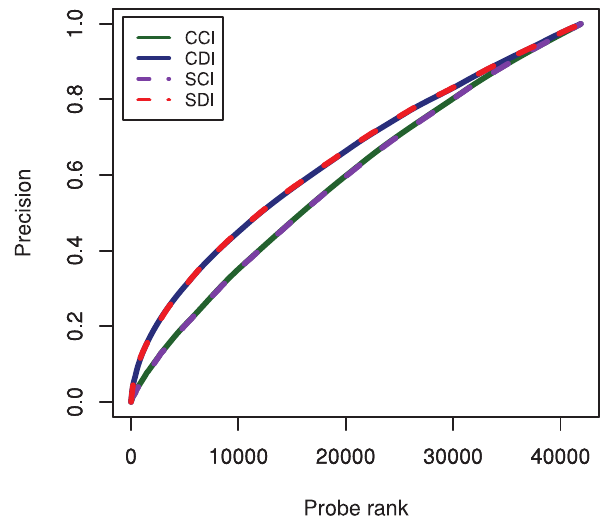
Figure 7. Average precision curves, calculated as the number of top n position weight matrix-based scores and experimental PBM fluorescence intensities in common. Precision curves were generate for cross scoring of completely-identical pairs (CCI), cross scoring of domain-identical pairs (CDI), self scoring of completely- identical pairs (SCI), and self scoring of domain-identical pairs (SDI) listed in Figure 1. The average precision is nearly exactly overlaying for CCI and SCI, as well as CDI and SDI, owing to the ability of self and cross PWM scans to equivalently capture the DNA binding properties in the PBM data. As with the Spearman correlation coefficients in Figure 4, the average precision for the domain-identical data set actually outper- formed the completely-identical transcription factor pair scoring, reflecting the more challenging nature of the completely-identical data set (see text for